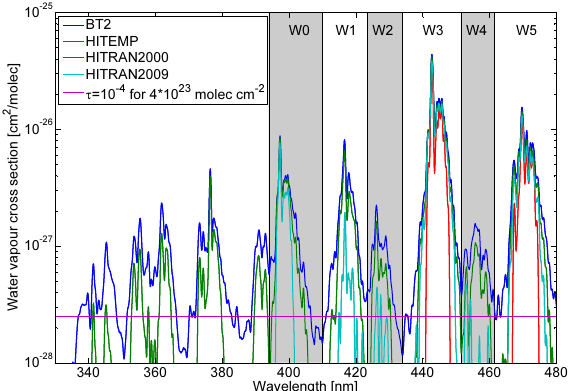
Figure 1. Overview of a subset of published water vapour absorp- tion cross-sections convolved to a spectral resolution of 0.5nm. Also indicated is a typical line detection limit for a differential OD of 10 − 4 at a water vapour column density of 4 × 10 23 moleccm − 2 (purple line) at a spectral resolution of 0.5nm. The wavelength in- tervals W0–W5 are described in the text; integrated absorptions in these intervals are given in Table